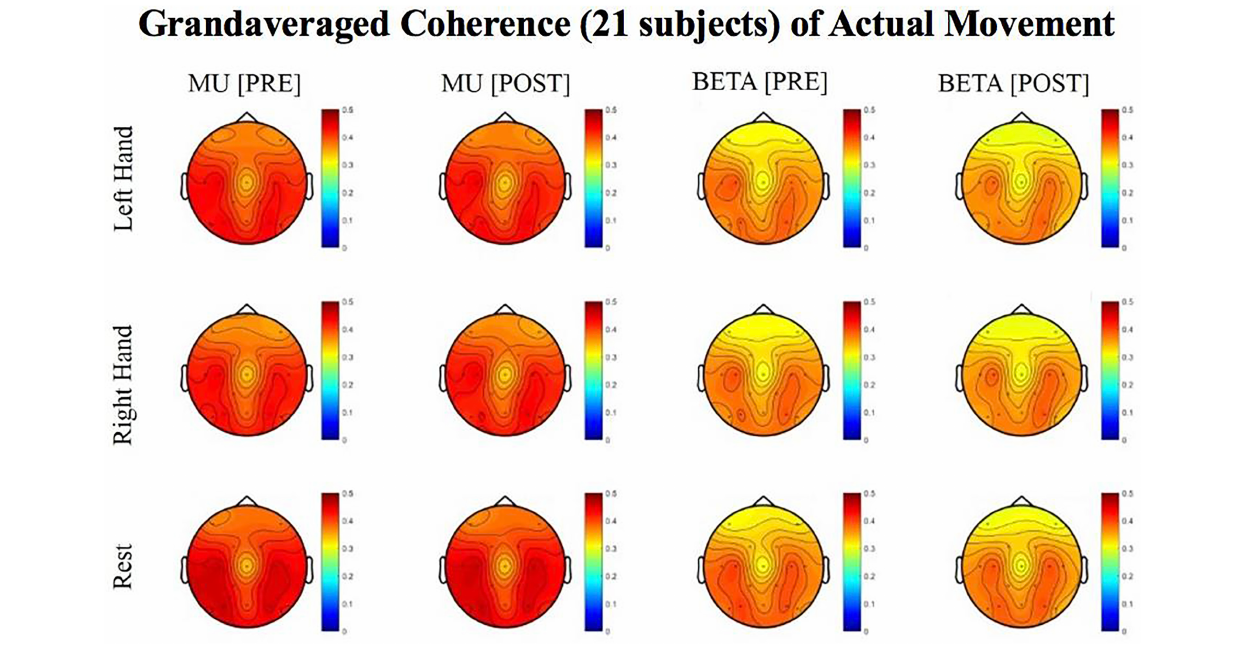
FIGURE 6 | Topoplots of grand averaged coherence values at group level ( n = 21) for Mu (8–12 Hz) and Beta (18–26 Hz) bands during attempted movement trials. Prescreening, open-looped training (PRE) and open-looped post screening BCI training (POST) runs (color bar: [0 = blue – 0.5 = red]). The majority of participants had a right lateralized lesion.